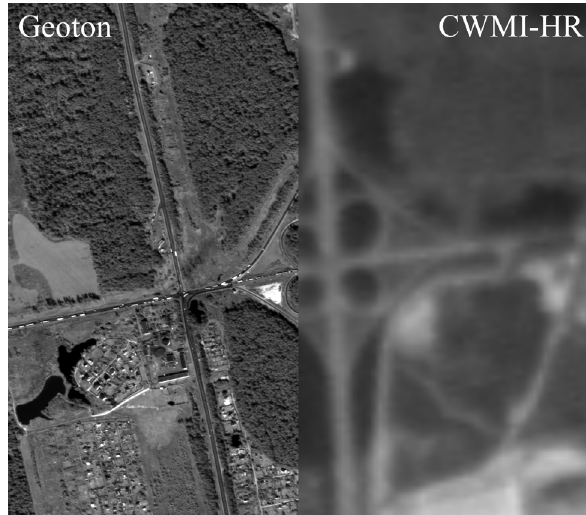
Figure 3. Example of the simultaneous output of data from “Geoton” and CWMI-HR The task of forming structurally reconstructed image from